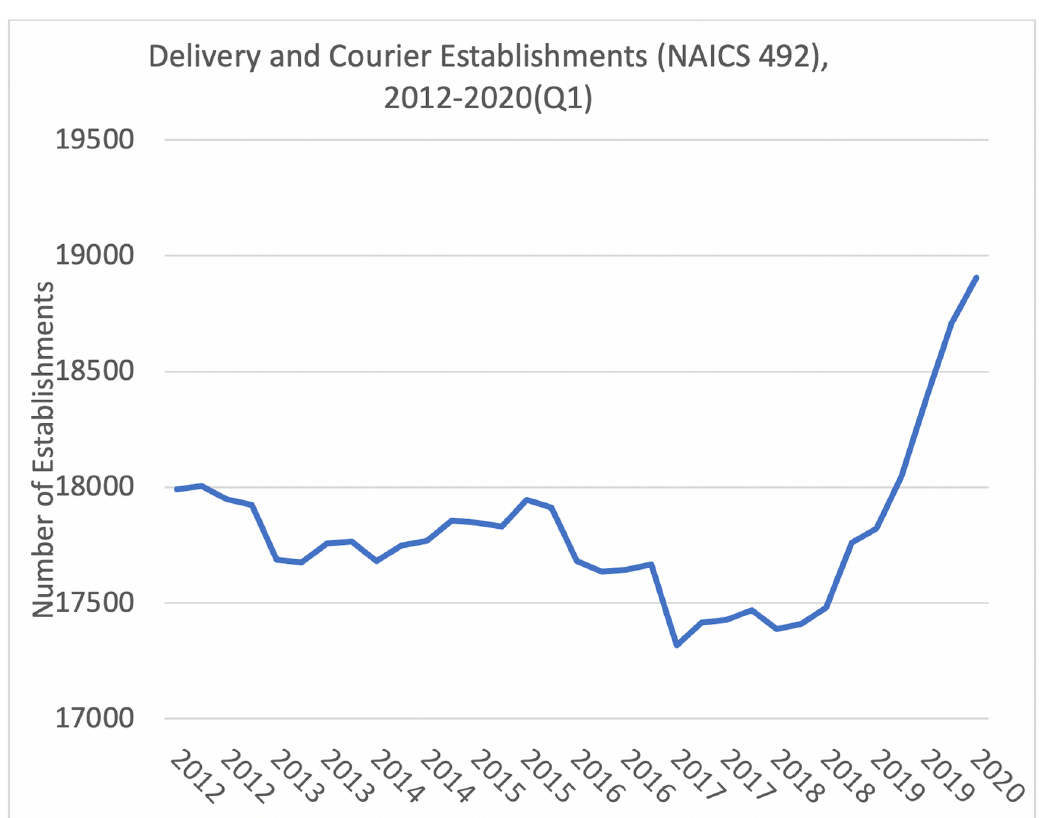
Figure 3: Trend in total number of parcel delivery establishments nationally, 2012–2020. Data come from Quarterly Census of Employment and Wages. Consolidation reverses in mid-2018, with the launch of Amazon DSP franchise